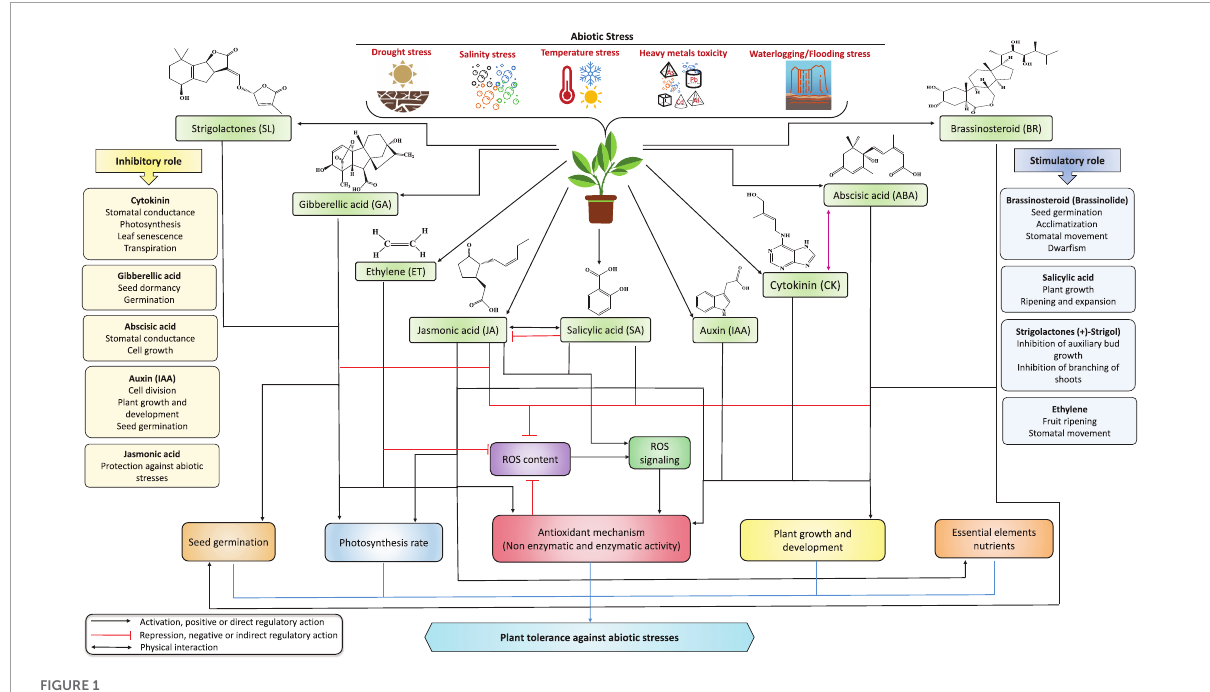
FIGURE1 The role of phytohormones in improving plant tolerance against multiple abiotic stresses. Under stress conditions, phytohormones can modulate the stress intensity in plants by triggering defense mechanisms and thus regulate physio-biochemical processes by increasing plant tolerance to environmental stress. CK, GA, ABA, IAA, and JA mainly play inhibitory roles, whereas BRs, SA, SLs, and ethylene play stimulatory roles in improving several physiological and biochemical mechanisms under stress conditions. Notably, ABA is a primary driving force, playing a vital role alone or combined with other hormones under stress. Furthermore, CKs and auxin play a dual role (inhibitory and stimulatory) by regulating plant growth and development